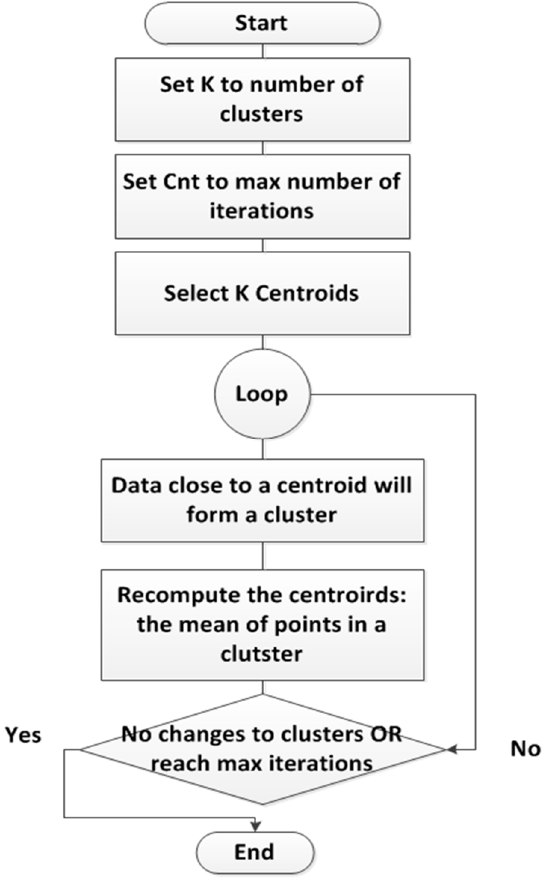
Figure 10. Main steps of the K-means algorithm .